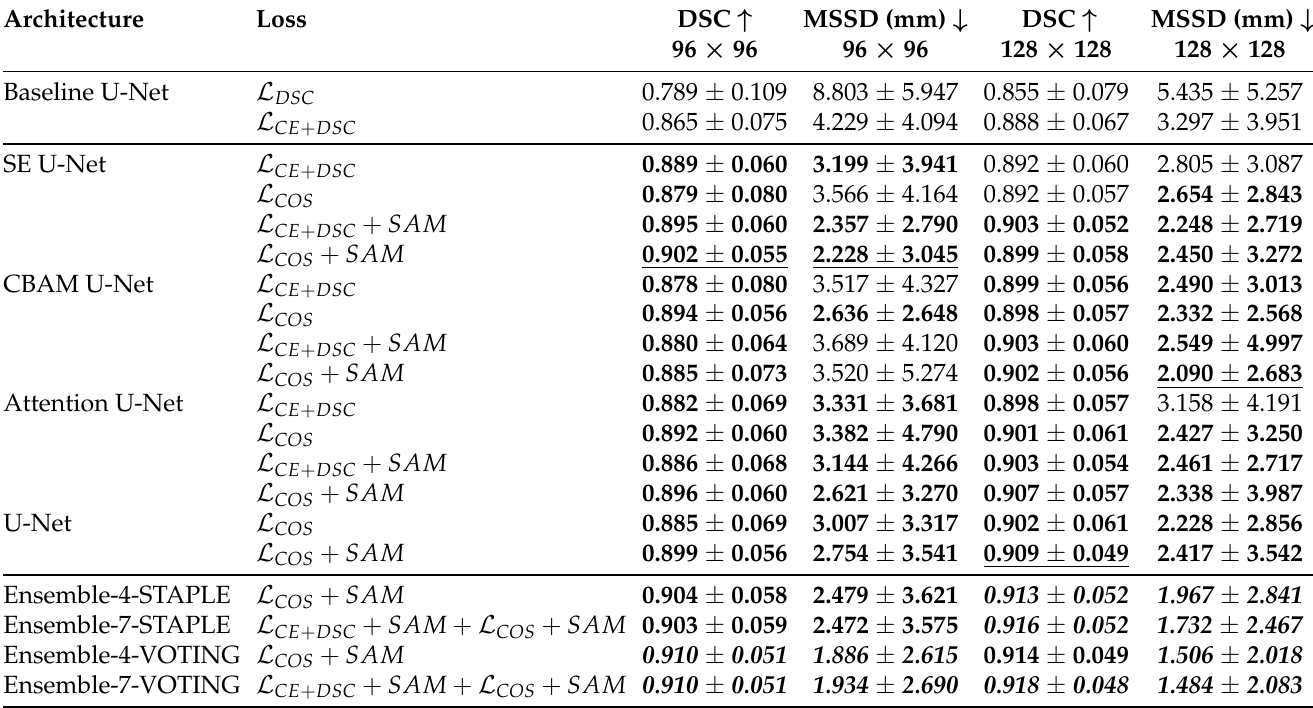
Table 1. The DSC and MSSD (in mm) values for various networks with loss functions as DSC ( L DSC ), cross-entropy+DSC ( L CE + DSC ), and cosine loss ( L COS ). The experiments were performed for two patch sizes: 96 and 128, with the numbers in bold implying significant difference ( p -value < 0.05) between the baselines and the corresponding network configuration. The underlined numbers signify the best in the respective category excluding ensemble results. As can be seen, adding attention to the U-Net can improve the results significantly (Attention and CBAM U-Nets). Furthermore, cosine loss alone (U-Net) or with Attention and CBAM U-Nets provides better DSC than the corresponding cross-entropy+DSC loss networks. Finally, the ensembles outperform the best model in each category. The ensembles in italics imply significantly better results ( p -value < 0.05) than the corresponding best performing